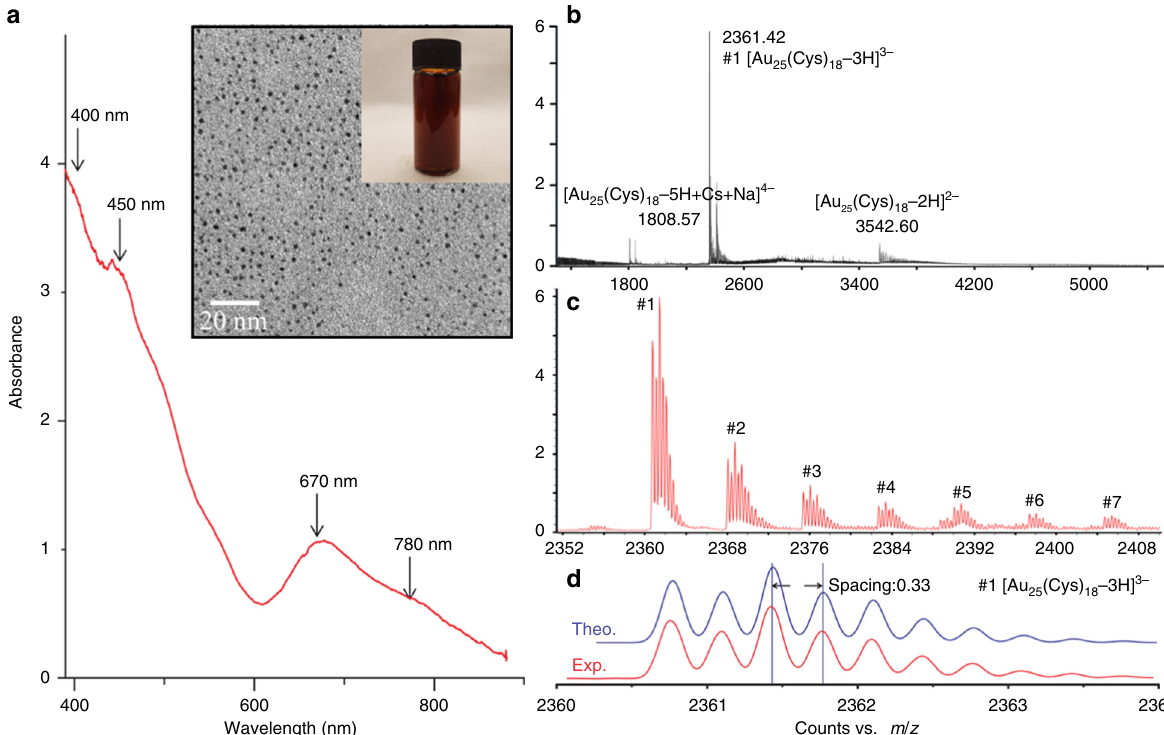
Fig. 1 Characterization of synthesized [Au 25 (Cys) 18 ]. a UV – Vis spectrum of [Au 25 (Cys) 18 ] solution (inset shows the picture and TEM image of [Au 25 (Cys) 18 ] solution). b , c ESI-mass spectra of [Au 25 (Cys) 18 ]. d Comparison between theoretical and experimental isotope pattern of #1